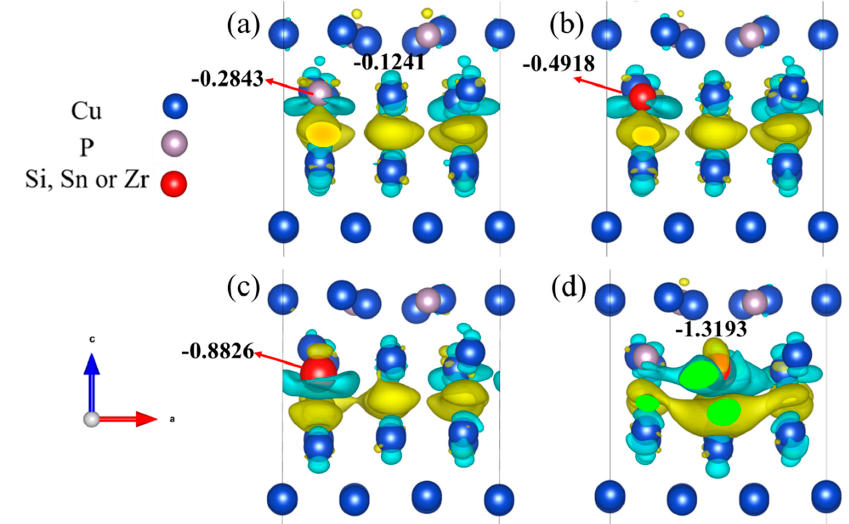
Figure 8. Schematic of the three-dimensional charge density differences of CuP-X/Cu interface: ( a ) CuP/Cu; ( b ) CuP-Si/Cu; ( c ) CuP-Sn/Cu; ( d ) CuP-Zr/Cu.